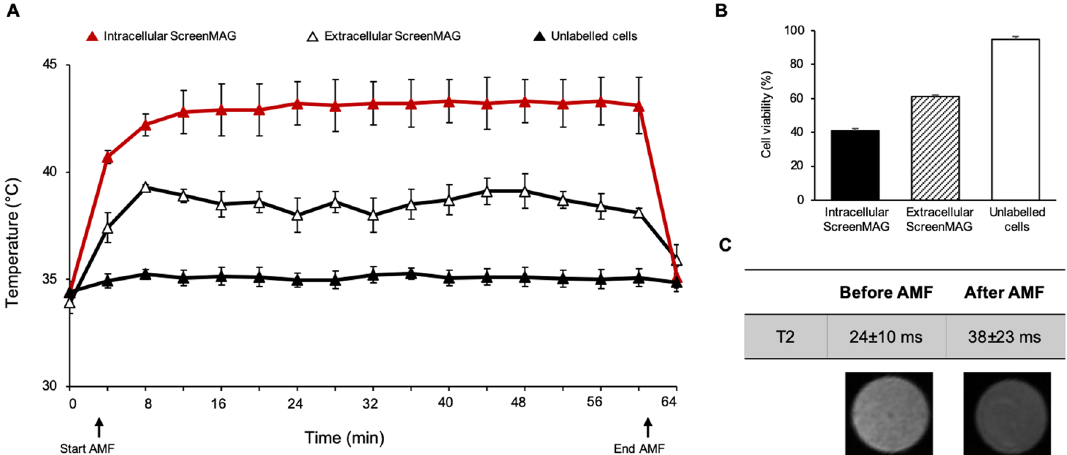
Figure 4. In vitro AMF application and corresponding MRI. ( A ) Temperature curves after application of an alternating magnetic field (AMF) (473 kHz and field strength of 13 kA m −1 ) (black arrow) on ScreenMAG- labeled U87-MG cells, extracellular ScreenMAG and unlabeled cells. ( B ) Cell viability of intracellular ScreenMAG, extracellular ScreenMAG and unlabeled cells after AMF application during 1 h. ( C ) T2 images and values before and after AMF of ScreenMAG-labeled cells (2 × 10 6 cells) at 4.7 T. T2 values of unlabeled cells is 134 ms ± 6 Figure 5B represents the number of mice included or excluded from the statistical analysis. Based on the exclu- sion criteria, only 2 mice in the control group and 1 mouse in the AMF group were excluded due to abnormal tumor growth inhibition ratio (T/C). Figure 5C depicts T/C according to the two mice groups. At 42 days, a weak diminution of tumor growth was observed in the AMF group, even though no statistical significance was calculated ( P = 0.078). A representative example of MR images of the tumors of each group at 42 days can be seen in Fig. 5D. A smaller tumor volume in mice receiving the treatment could be measured compared to control mice. Qualitative analysis of intracellular iron was performed on brain slides of mice submitted or not to AMF application (Fig. 6A–D). Although iron was mostly detected within cancer cells when no AMF was applied, the ScreenMAG particles were found equally distributed in the extracellular and intracellular spaces one day after AMF application. However, 7 days after the AMF application, IOP were mainly detected within the cells.